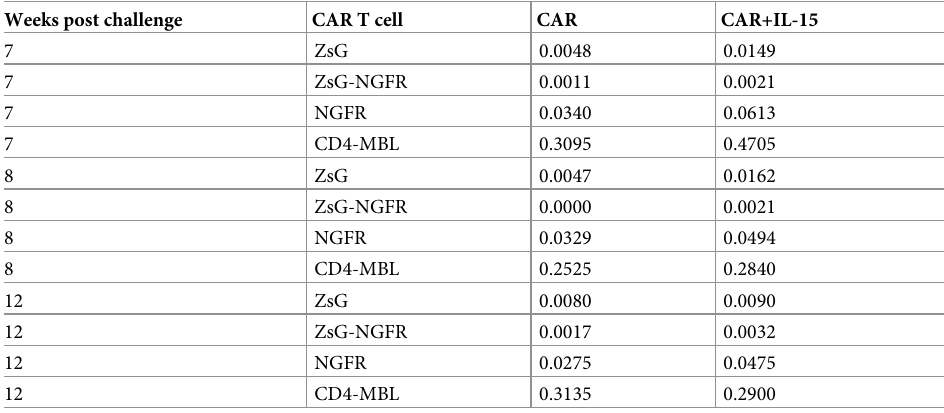
Table 2. CAR T cell frequency in